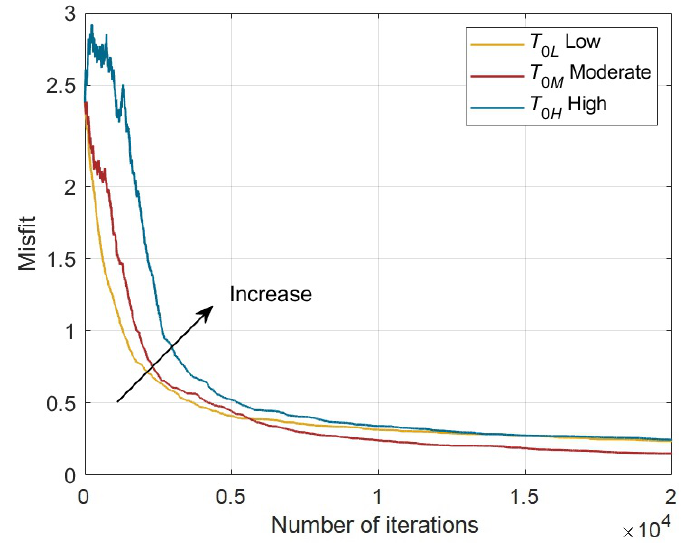
Figure 5. Misfits varying with iteration numbers by using the different initial temperatures. The arrow shows the direction of temperature increase. The definitions of curves are given in the